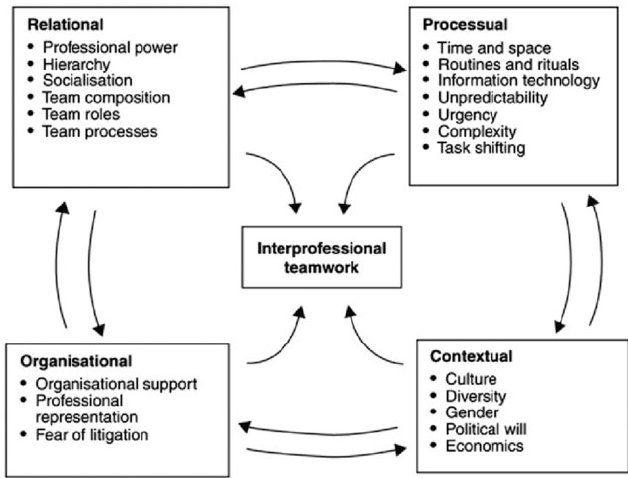
Figure 1. Conceptual Framework for Interprofessional Teamwork. Source: Reeves et al. [33], IGI Global, reprinted by permission.